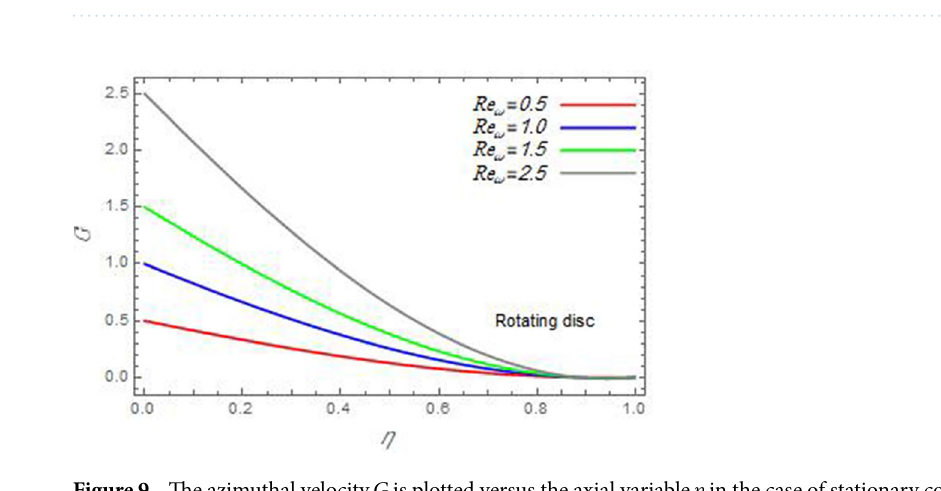
Figure 9. The azimuthal velocity G is plotted versus the axial variable η in the case of stationary cone to depict the effect of the Reynolds number Re ω